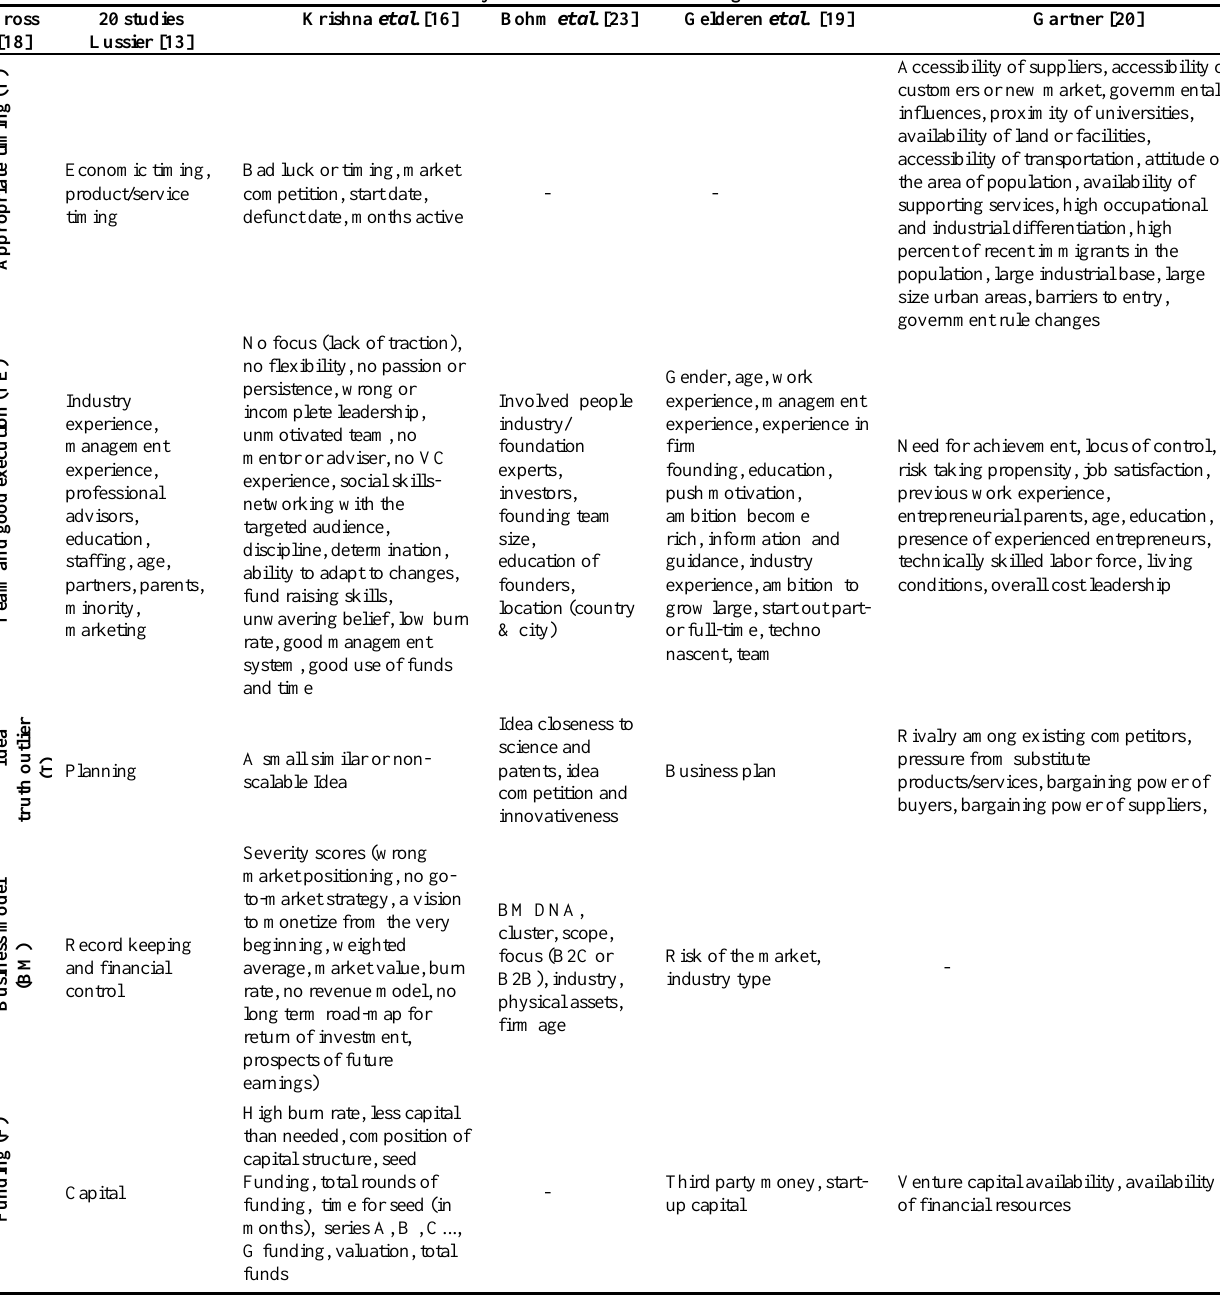
Table 1. Variables introduced and used by different studies that are organized in the Gross’s five sectors.